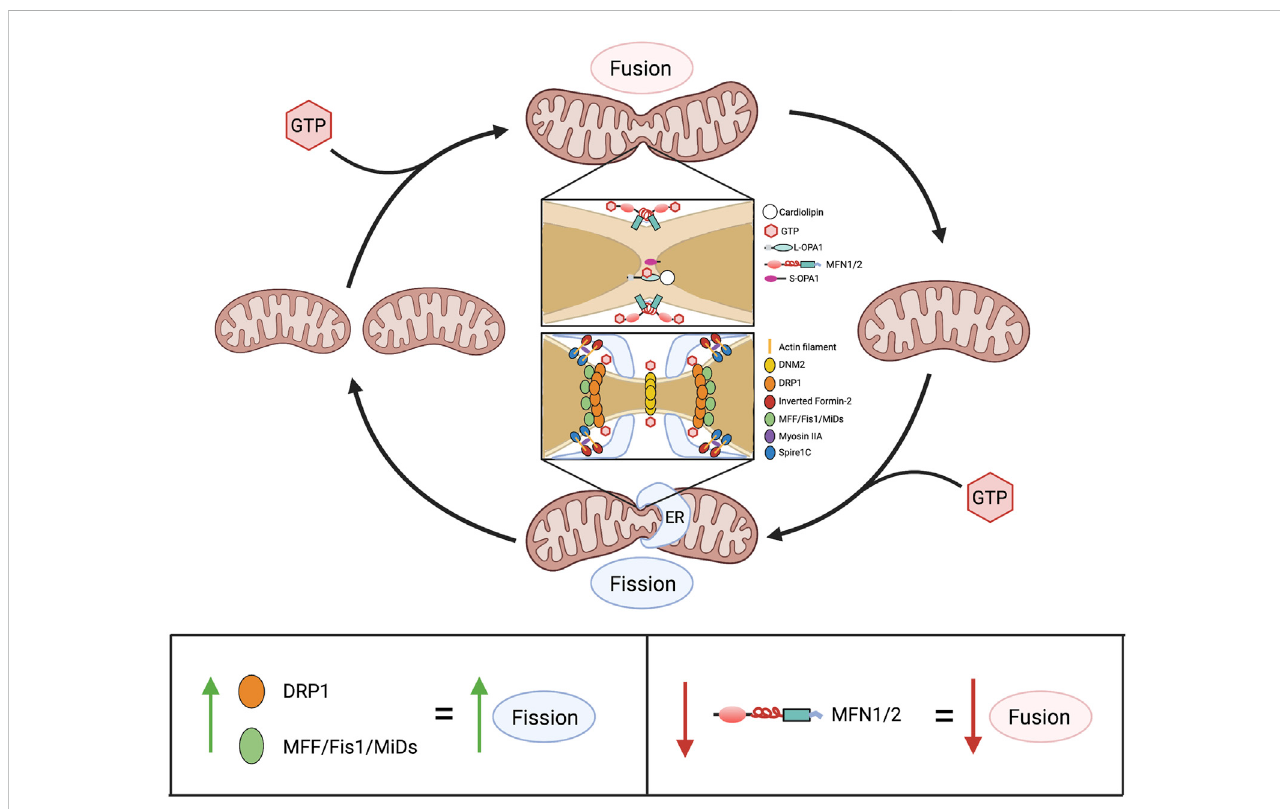
FIGURE 6 Overviewofmitochondrialdynamics.Above:Mitochondrialfusionand fi ssionareGTP-dependentmechanismsthatcausemitochondriatojointogether and divide, respectively. In fusion, association between two adjacent mitochondria is initially made via the cytoplasm-facing, C-terminal heptad repeat domains of MFN1 and/or MFN2. This produces a coiled-coil structure, with GTP hydrolysis by an N-terminal GTPase domain drawing adjacent outer mitochondrialmembranesclosertogether,enablingfusion.Subsequently,GTPhydrolysisbyL-OPA1,inL-OPA1-cardiolipinassociations,enablesfusion oftheinnermembranes, fi nalizingtheunionbetweenmitochondria.In fi ssion,serine-616-phosphorylatedDRP1(theactivatedformofDRP1)movesfromthe cytosol to the outer mitochondrial membrane where it binds one or more of its adaptor proteins (MFF, Fis1, MiD49 and MiD51), which are anchored on the outer mitochondrial membrane. This formation of fi ssion rings occurs at sites with increased mitochondrial DNA (not shown) that are demarcated by association with the ER. Formation of DRP1 oligomers and their interaction with ER and actin fi lament structures, including spire1c and inverted formin-2, contribute to the fi ssion machinery. Multimers of DRP1 and the other fi ssion-mediating proteins encircle the mitochondria. The fi ssion apparatus constricts following DRP1 GTP hydrolysis. DNM2, which creates a fi ssion apparatus of even smaller diameter than DRP1, is postulated to complete the fi ssion process, although this remains controversial. Below: Alterations in expression of mitochondrial dynamics proteins and consequences for the fusion- fi ssion balance.